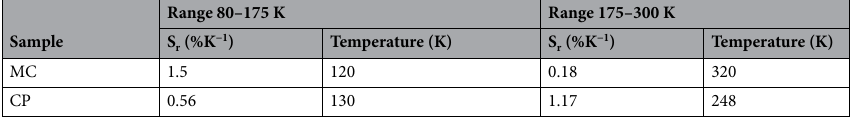
Table 1. Maximum value of relative sensitivity at given temperature in two: low (80–175 K) and high (175–300 K) temperature